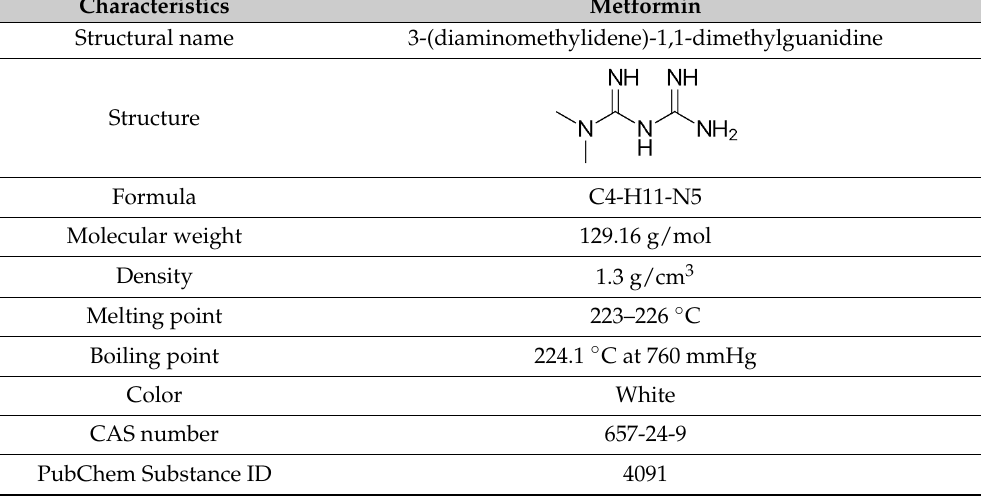
Table 1. Metformin’s biometric information.